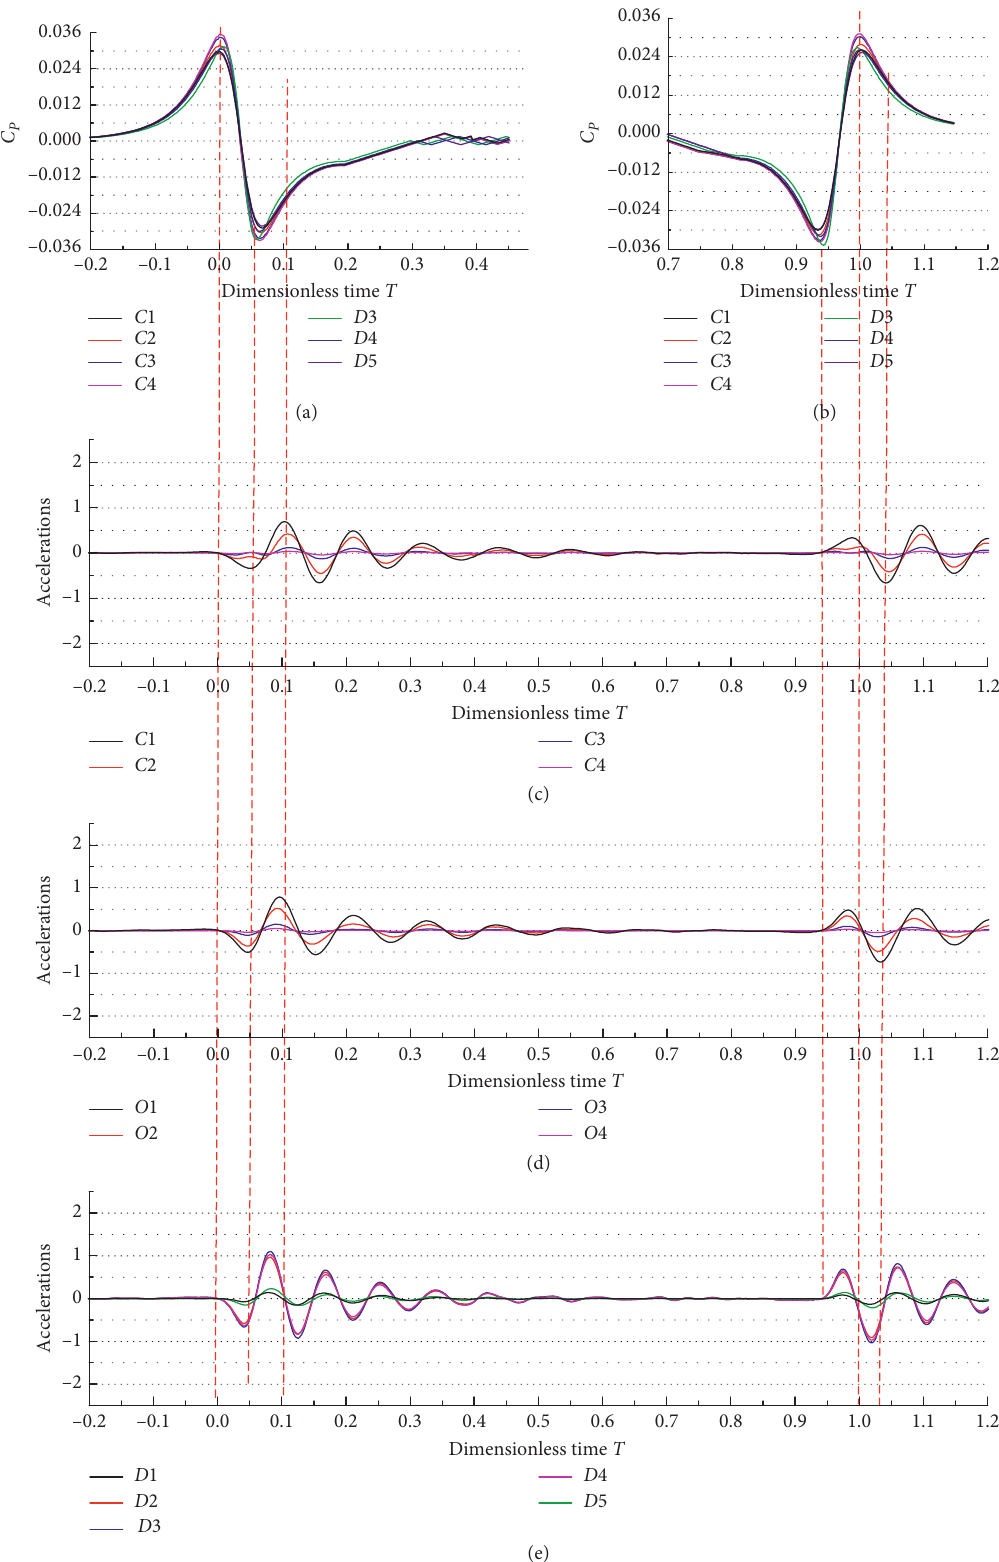
Figure 18: Time histories of the pressure coefficients and peak acceleration under dimensionless time when train on the far-line: (a) head pulse, (b) tail pulse, (c) peak acceleration on the closed side, (d) peak acceleration on the open side, and (e) peak acceleration on the top